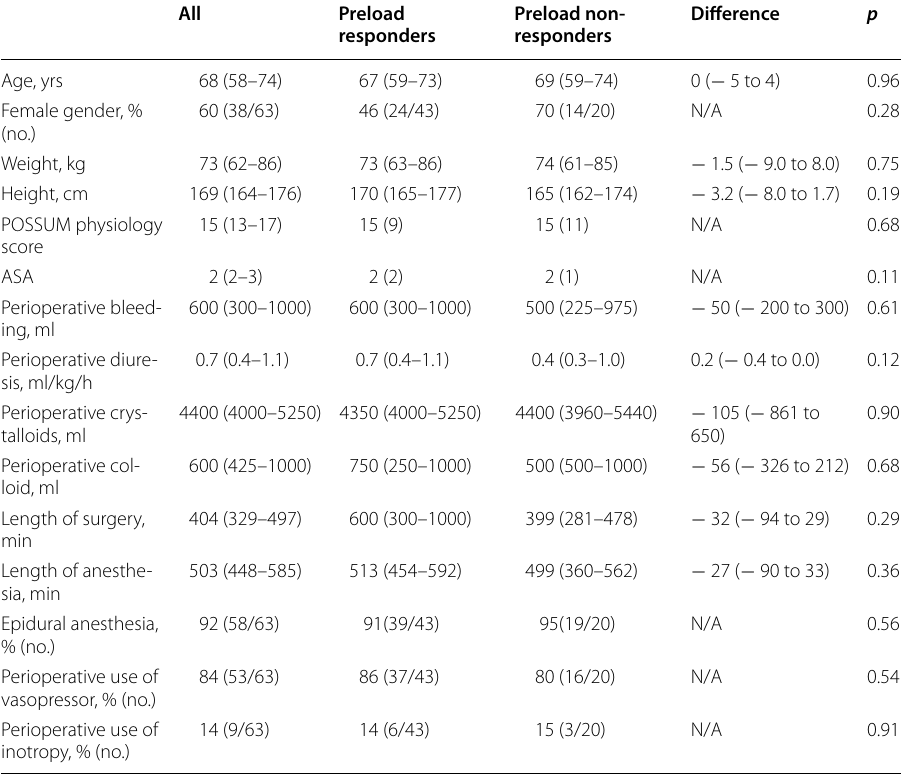
Table 3 ASA—American Society of Anesthesiologists physical status, POSSUM—Physiological and Operative Severity Score for the enUmeration of Mortality and